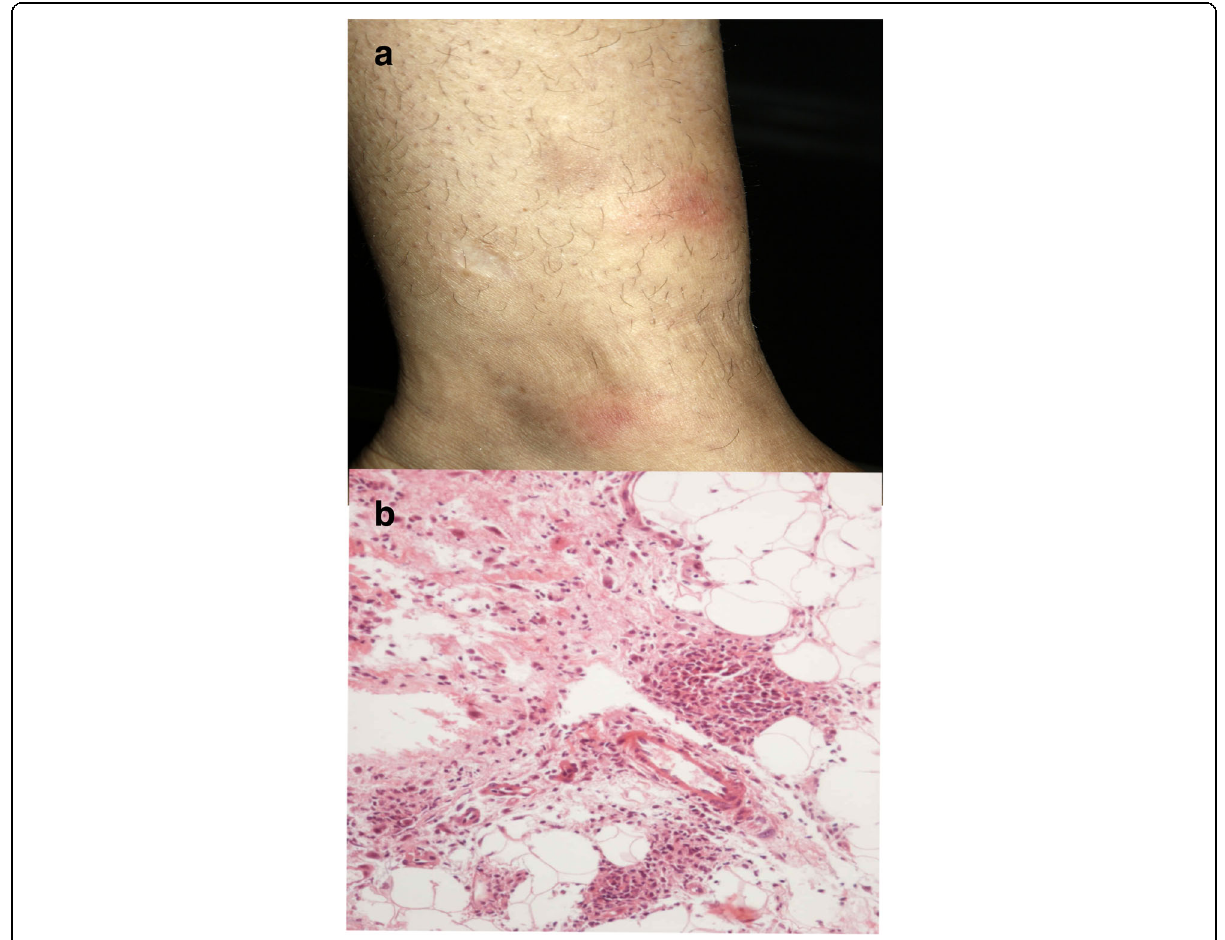
Fig. 3 Erythema nodosum. a Red nodules anterior on the anterior aspect of the lower limb. b Septal thickening with lymphohistiocytic infiltrate and formation of Miescher radial granulomas at the periphery of the subcutaneous fat lobule. H&E,